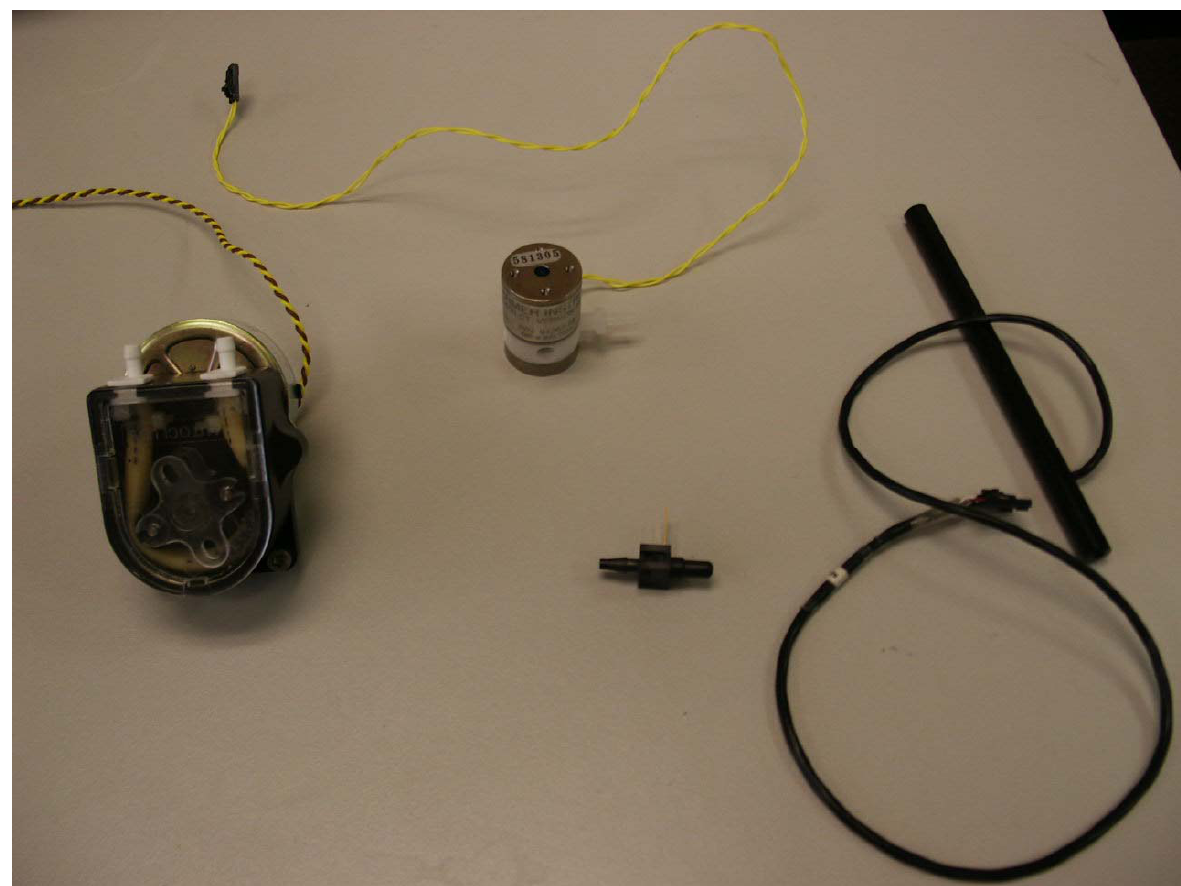
Figure 2. The major components of the fluid system – clockwise from left: peristaltic pump, solenoid valve, 545 CT cell (with custom connector installed), DP cell (before installation of custom circuit